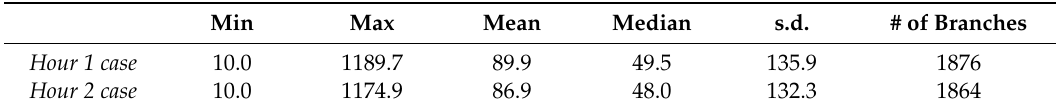
Table 13. Statistical Results of Branch Complex Power with Full AC Models with a Tolerance of 10 MVA for Hour 1 Case and Hour 2 Case.